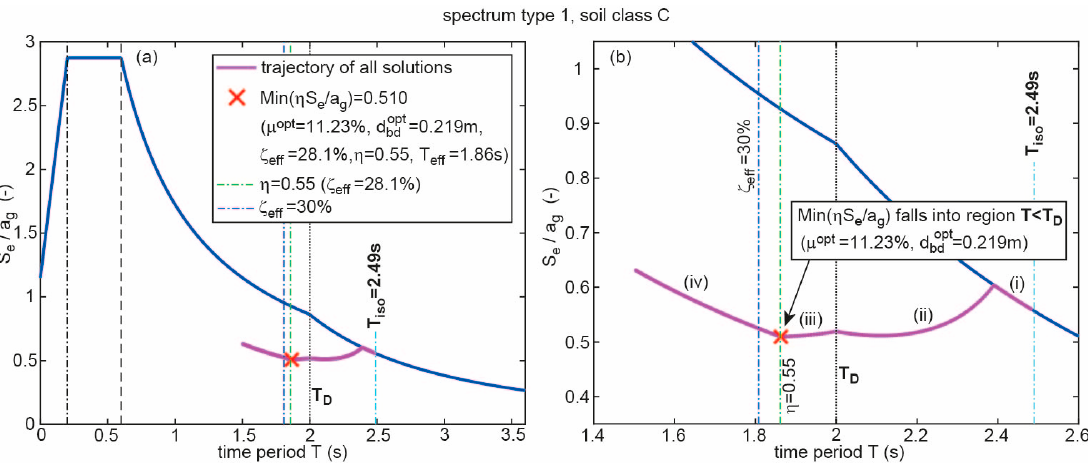
T = 2.49 s and ( b ) according close-up for spectrum type 1 iso